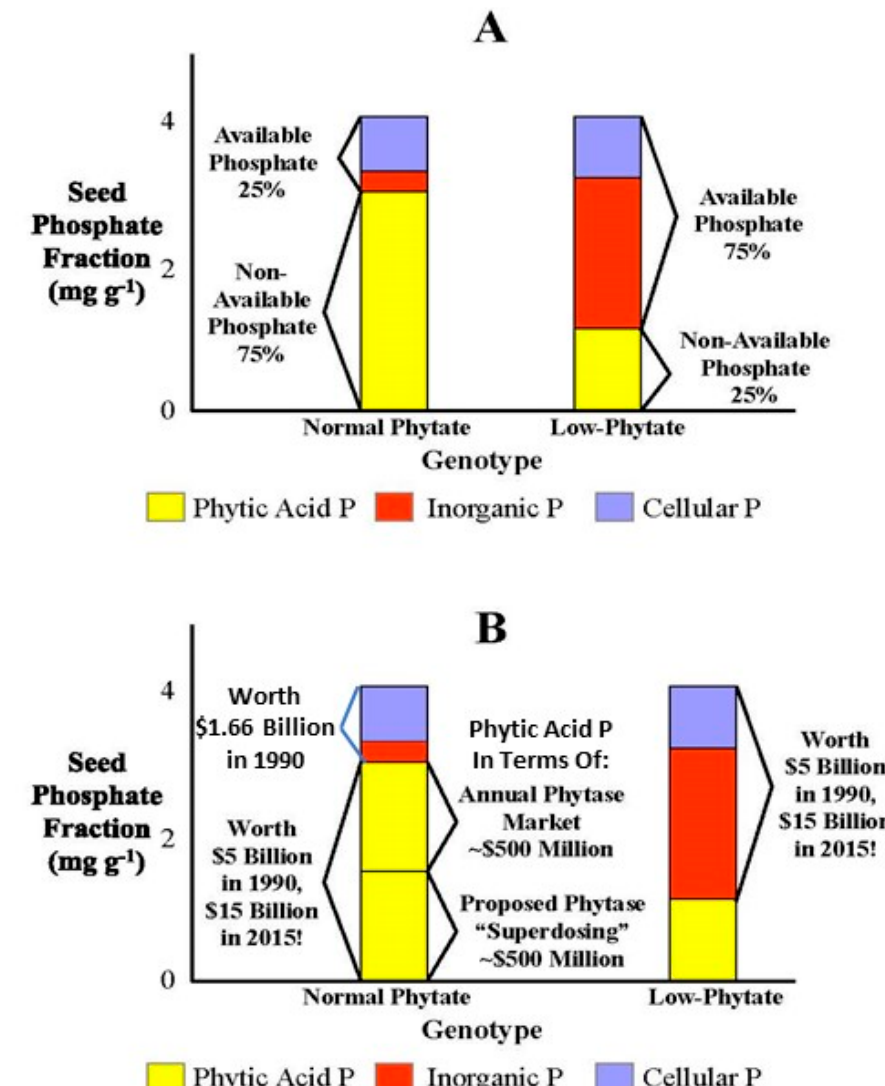
Figure 3. ( A ) Typical seed phosphorus (P) fractions and their bioavailability to non-ruminant animals, in a wild-type or “normal phytate” crop type versus a low-phytate line. “Available phosphate” and “non-available phosphate” refers to that fraction of seed total P that would be absorbed and utilized following consumption by non-ruminants. This is only an illustration for discussion purposes and does not represent actual data for any given crop or low-phytate line. Cereal crops usually have 3.0 to 4.0 mg Total P g -1 , such as in the illustration. Legume and oil-seed crops can often have 5.0 or more mg Total P g -1 , but the relative proportions of phytic acid P, inorganic P and “cellular P” remain similar to that observed in cereal grains. “Cellular P” refers to all P other than phytic acid P and inorganic P, such as P found in DNA, RNA, protein, carbohydrate, lipids, etc. ( B ) The same bar graph of seed P fractions but with: (1) the relative value in U.S. dollars of the respective seed P fractions, expressed in terms of the market price for rock phosphate (adjusted for inflation), in 1990 versus 2015 and (2) the relative value of the current “phytase market” and the proposed “superdosing” of phytase.